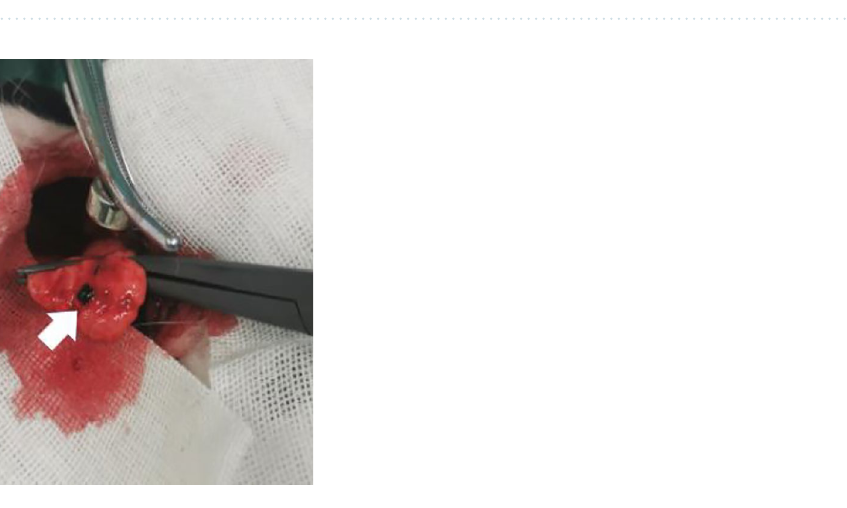
Figure 5. Magnetic gel in lung tissue (blue arrow) observed under X-ray.